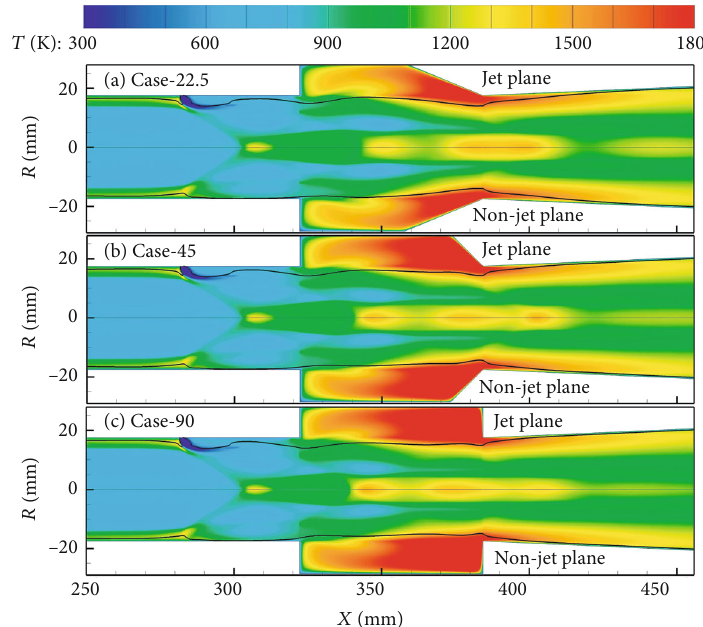
Figure 14: Temperature contours of all cases in the reacting fl ow fi eld; the black solid line is the isoline of sonic